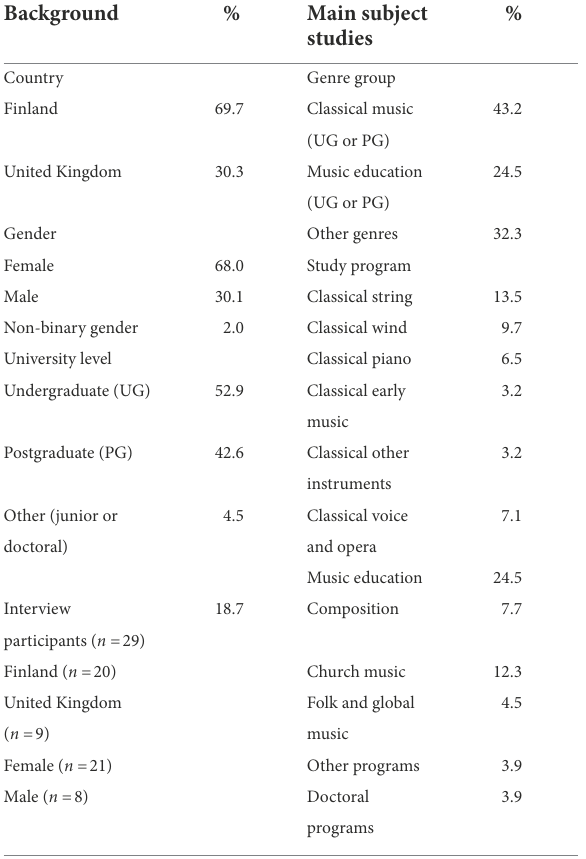
TABLE 2 Demographic characteristics of all participants in the sample (N =